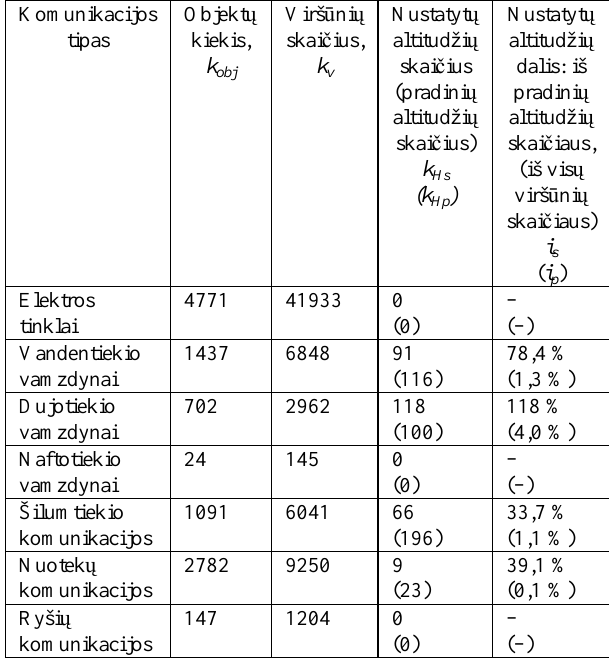
Table 3. Results of altitude transfer to utility lines